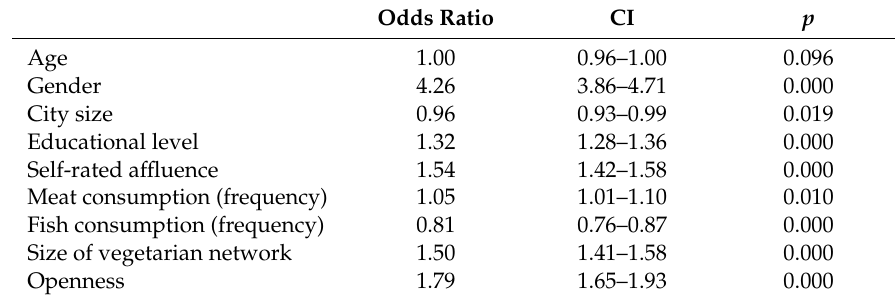
Table 2. Multivariate Logistic Regression predicting the belonging to Green Monday (GM) sample (coded 2) by contrast with the National Comparison (NC) sample (coded